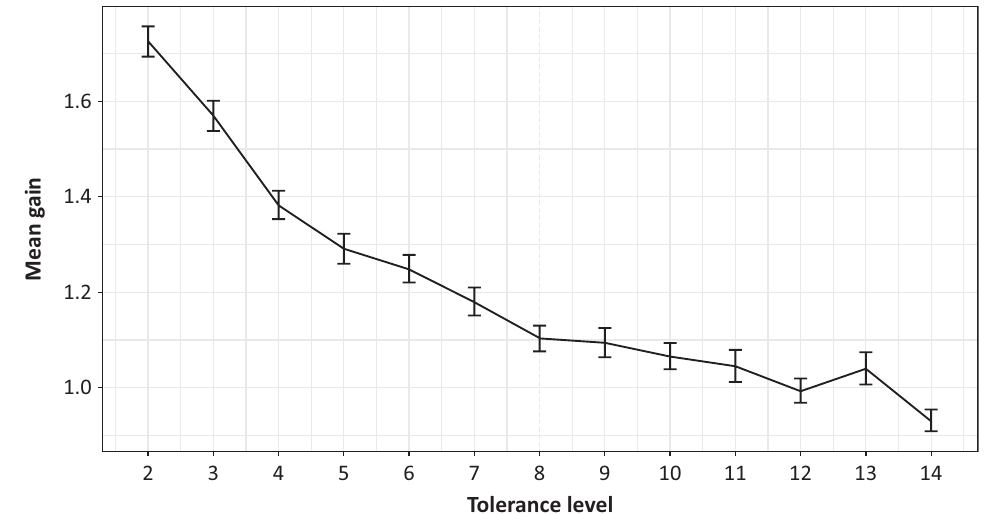
Figure 1. Relation tolerance level and mean gain. Note: Error bars represent standard errors ( + / −